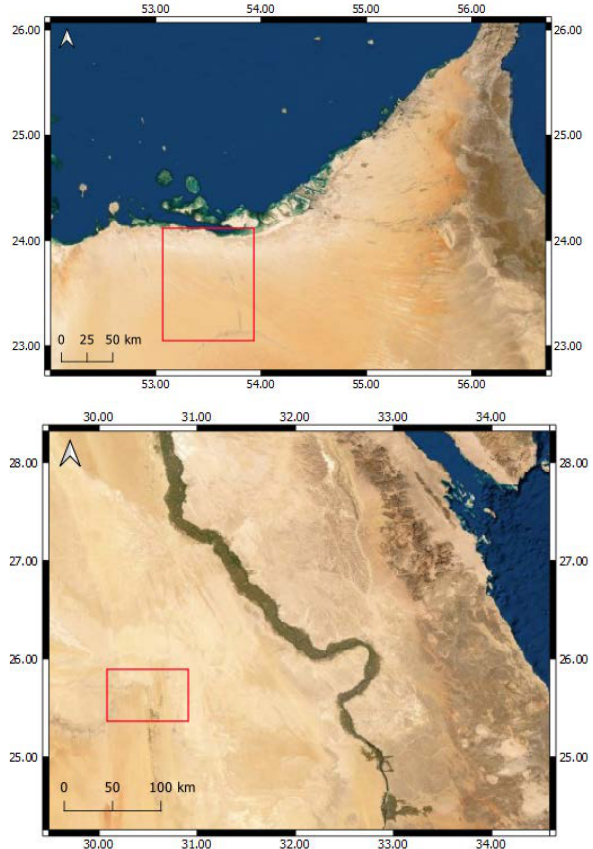
Figure 3. Regions of interest (red boxes) selected for the United Arab Emirates (top) and Egypt (bottom) use cases (© ESRI satellite Copyright). Coordinates are expressed in